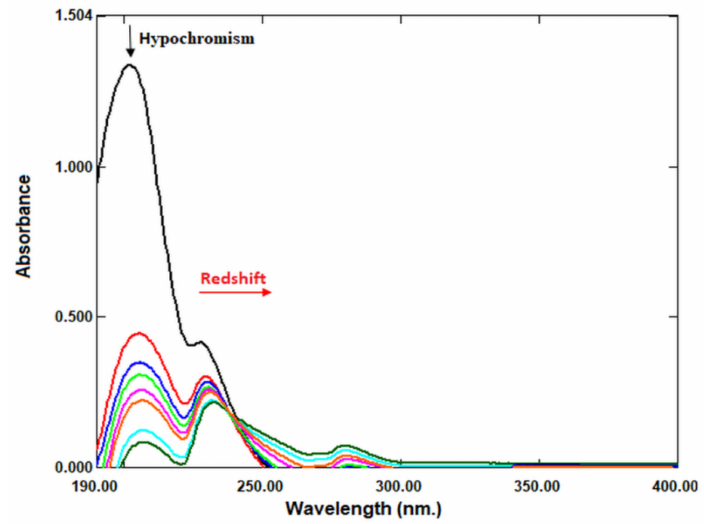
Figure 6. The absorption spectra of LNEO in the presence of increasing amounts of CT-DNA, and in the absence of CT-DNA (the black peak).